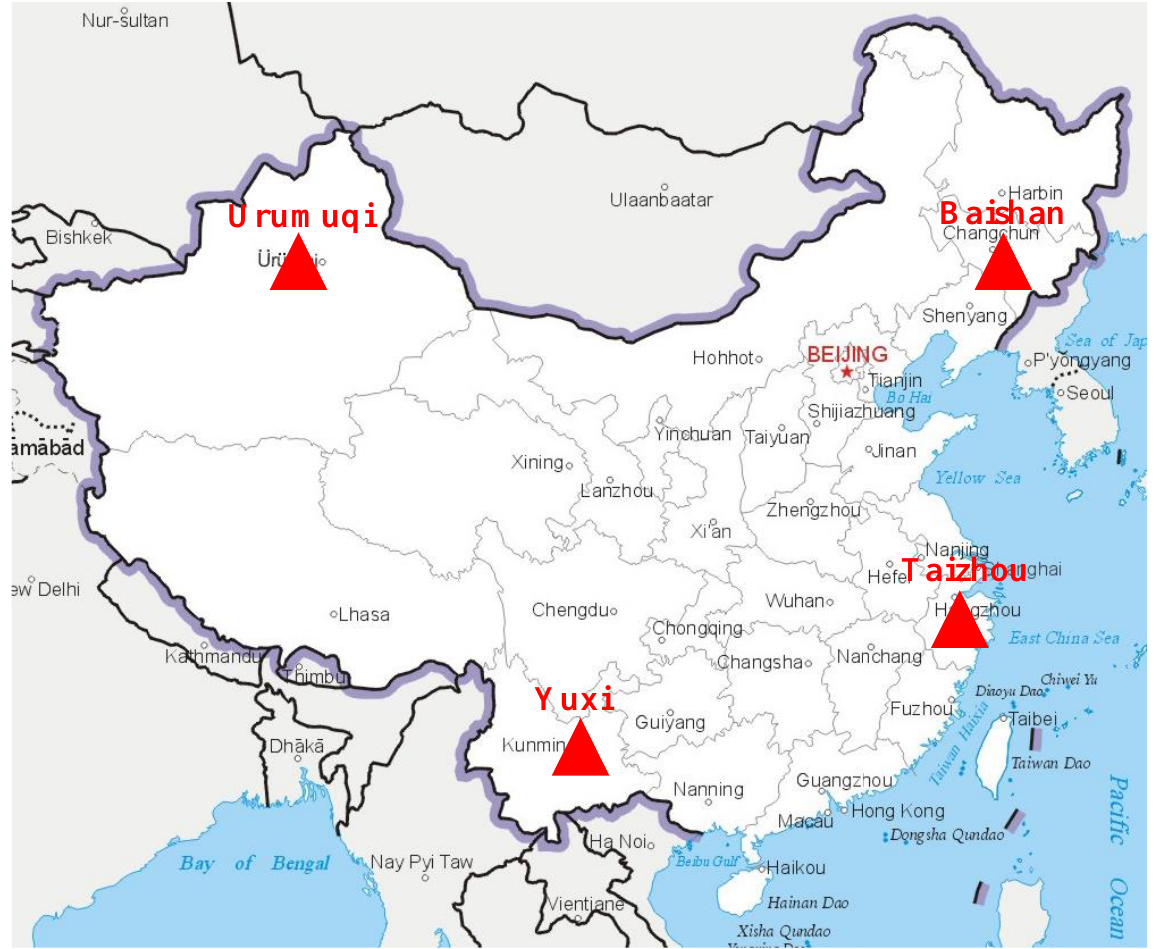
Figure 2. The configuration of our experimental lightning location network. The four lightning stations are located at Urumqi, Yuxi, Taizhou, and Baishan, as marked by red triangles on the map.